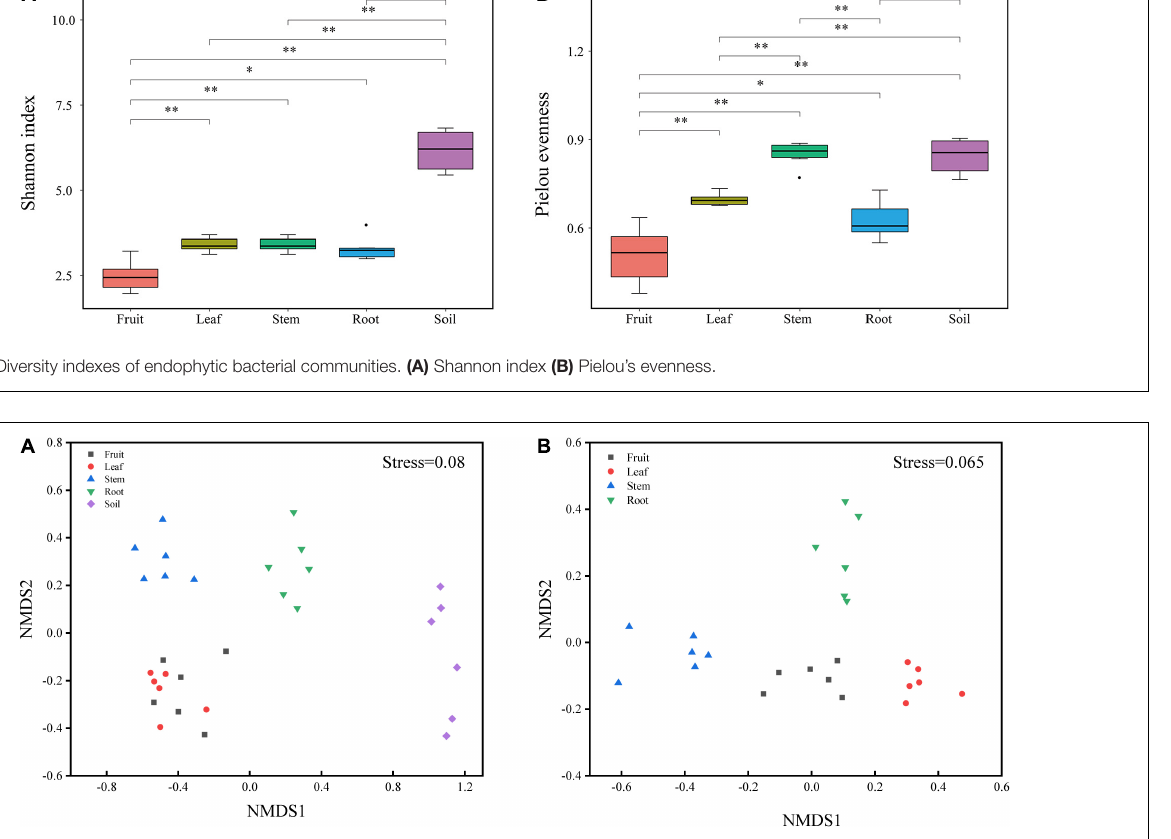
FIGURE 2 | Non-metric multidimensional scaling (NMDS) carried out with (A) OTU table based on Bray-Curtis distance (S = 0.08) and (B) predicted function gene table based on Bray-Curtis distance (S = 0.065).